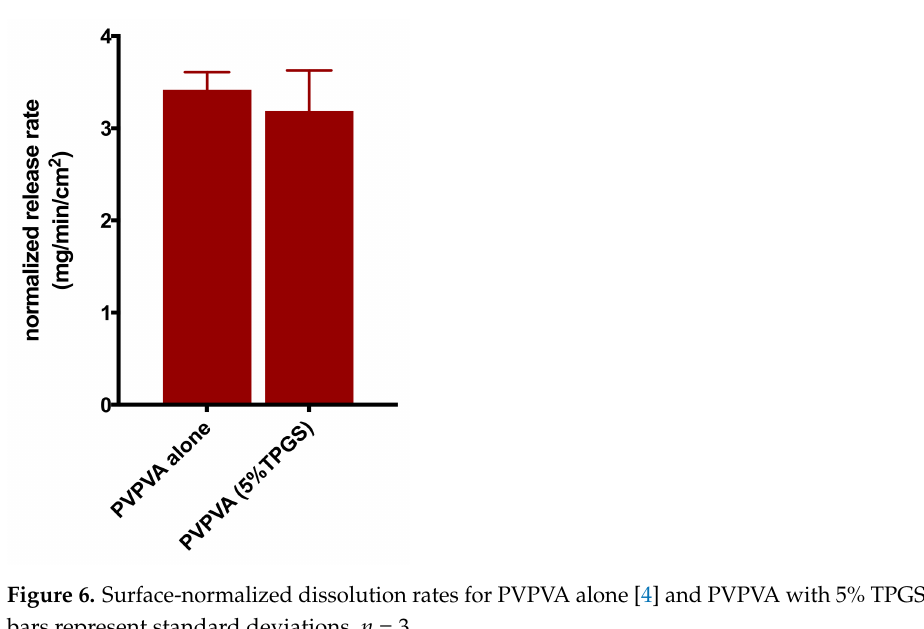
Figure 5. Limit of congruency (% drug loading by weight) for felodipine:PVPVA ASDs at different levels (0% [4], 2%, 5%, and 10% TPGS).